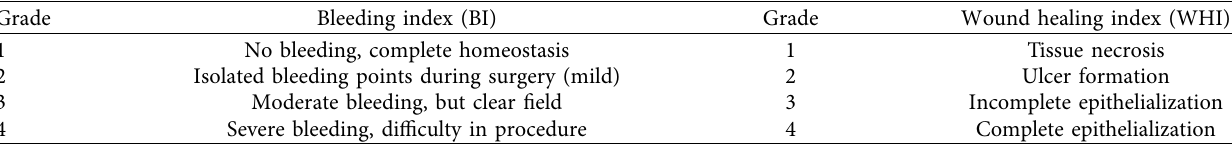
Table 3: Indices used for evaluation of bleeding and wound